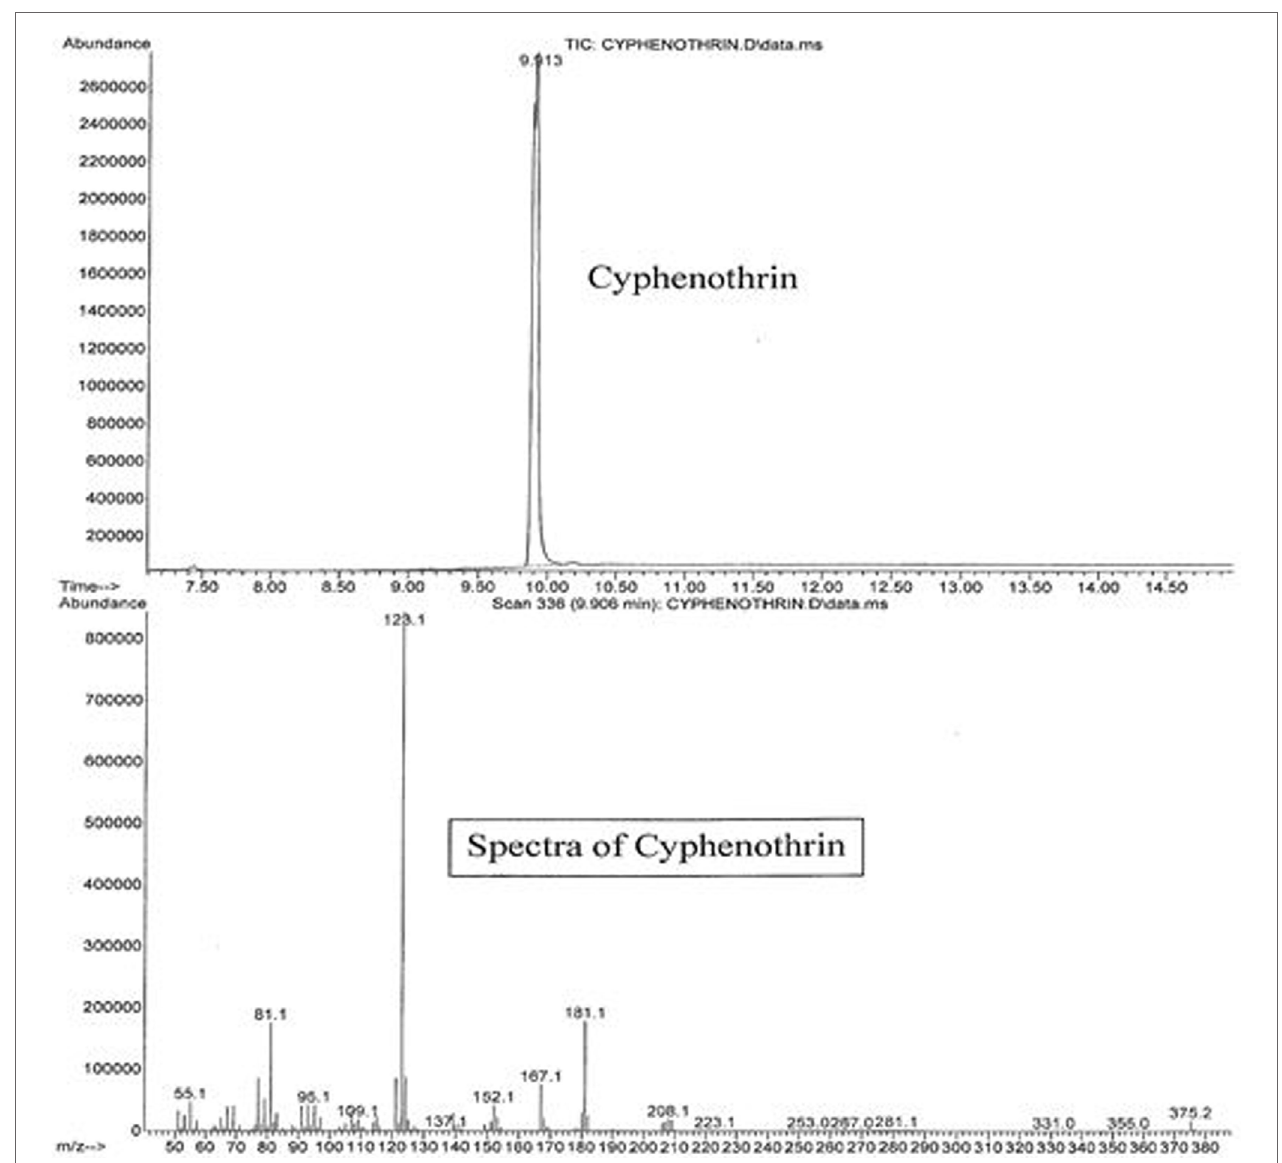
FigUre 3 | Total ion chromatogram (upper panel) and ion spectrum (lower panel) of cyphenothrin